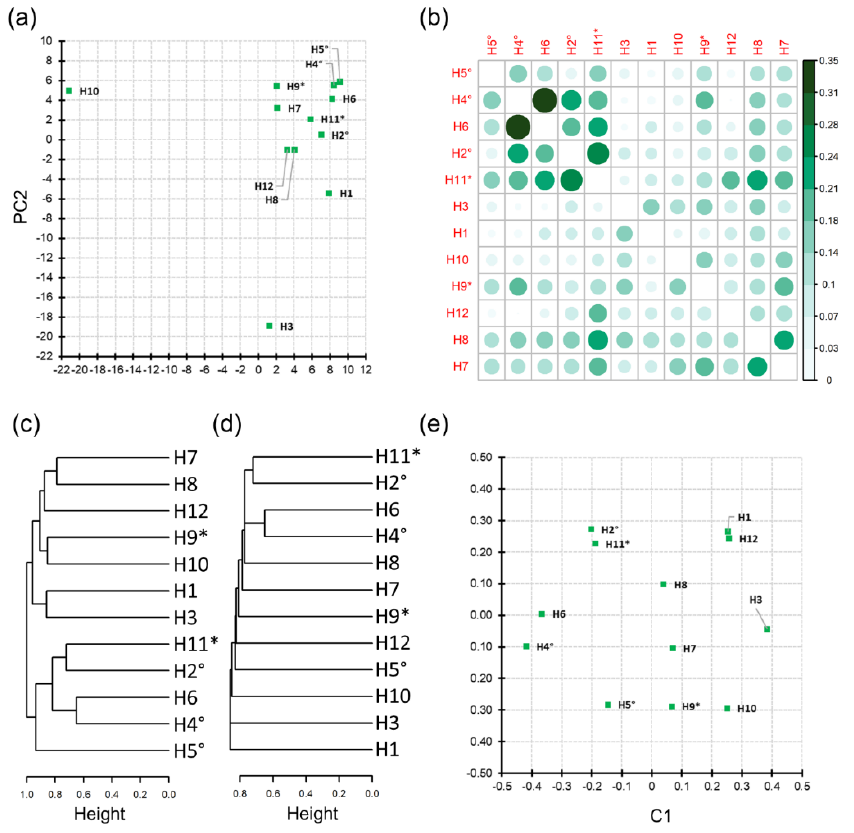
Figure 3. Analyses of honey sample similarity: ( a ) logistic PCA; ( b ) Jaccard similarity coefficient; ( c ) single-linkage clustering based on Jaccard distance; ( d ) complete-linkage clustering based on Jaccard distance; ( e ) multidimensional scaling of the Jaccard distance matrix. Samples provided by the same beekeeper are marked with the same symbol (* or °).